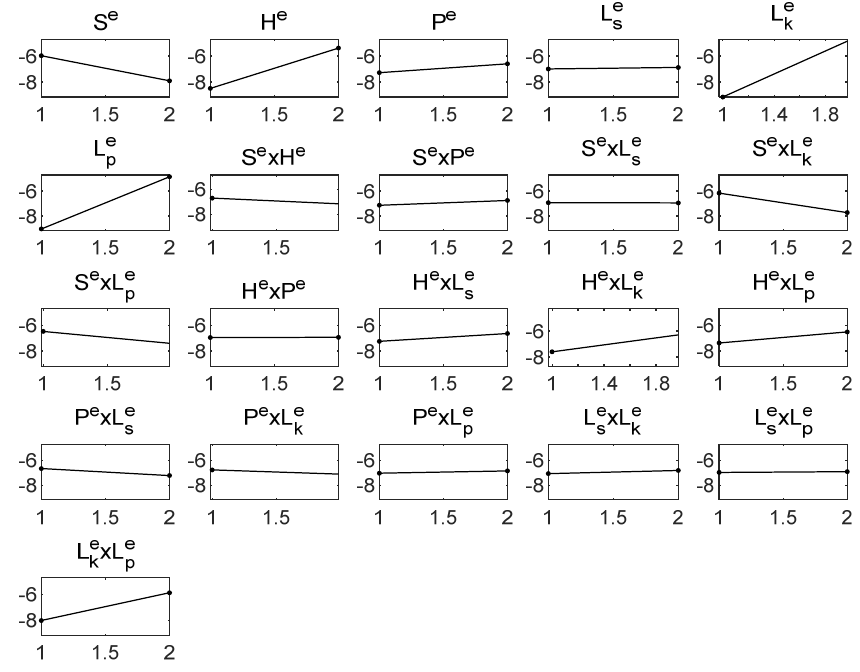
Figure 9. Return loss | S 11 | trend chart of flexible interconnection considering interaction effect.